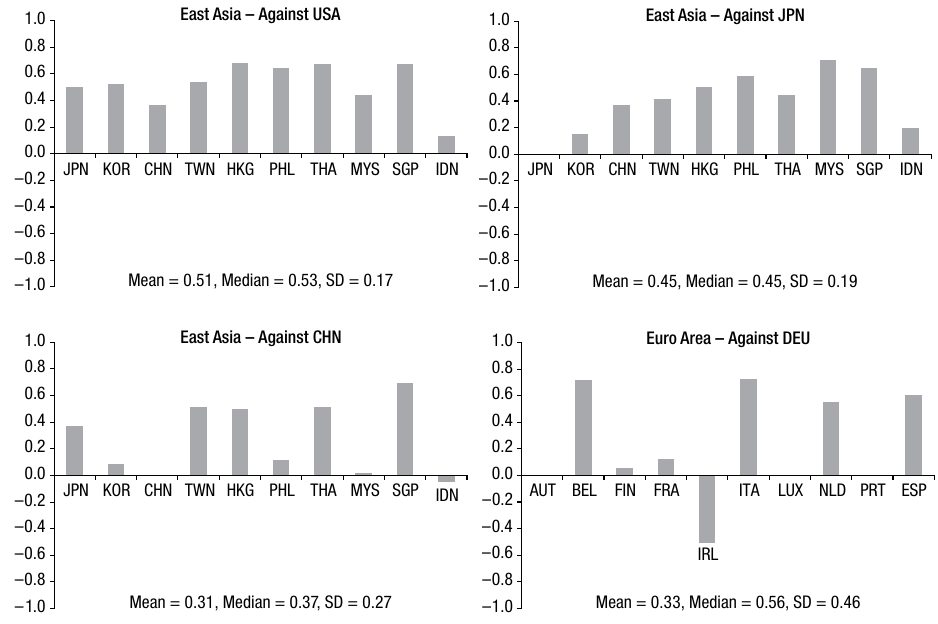
Fig. 5. Real interest rate cycle synchronization, 1999:1–2009:12 Source : IMF: IFS; Taiwan National